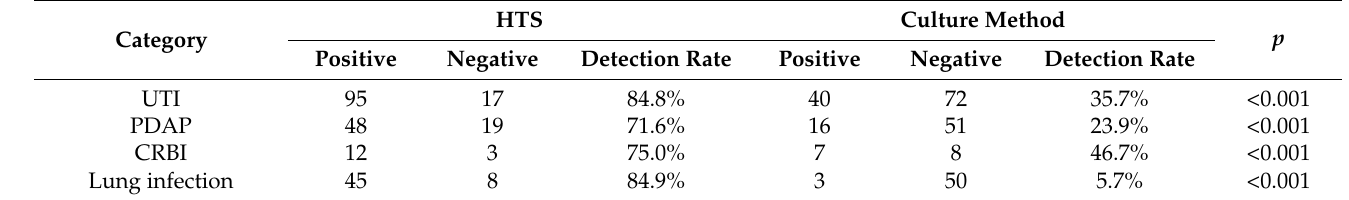
Table 2. Comparison of positive rate of detection between HTS and culture